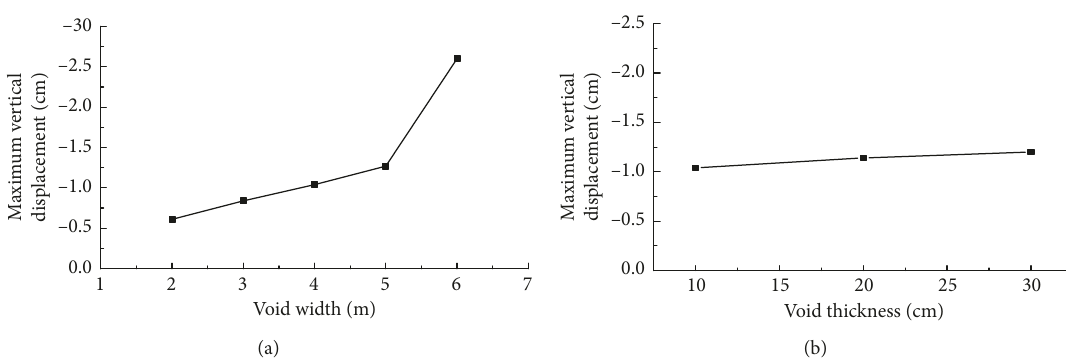
Figure 9: Peak value variation curve for vertical displacement of the inverted arch: (a) void thickness is 10 cm; (b) void width is 4 m.